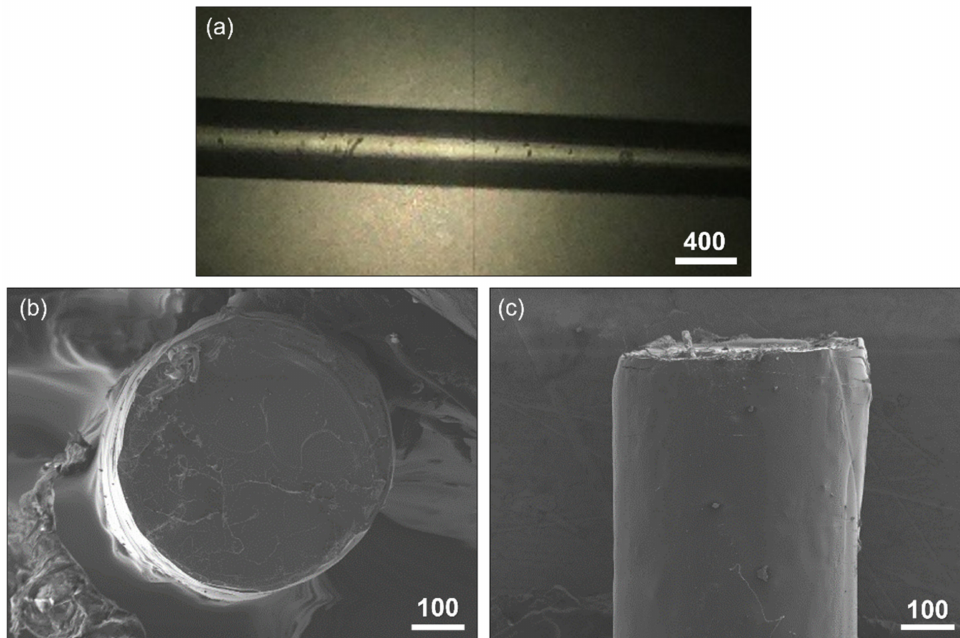
Figure 3. ( a ) Detail of the PLA filament with the profilometer. ( b ) Fractography of the filament with the SEM in which the excellent ovality can be observed. ( c ) Transversal view of the same broken filament. Scale bars in microns.